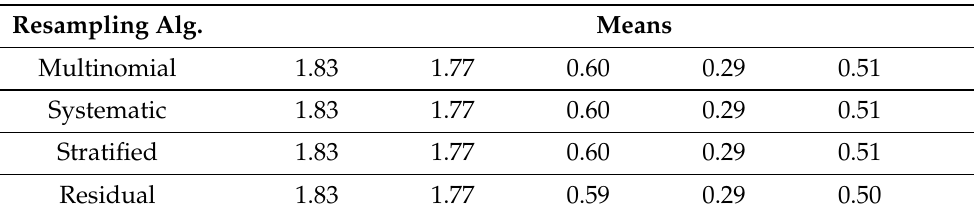
Table 2. Average number of times each of the samples is selected in a test containing 100,000 trials (weights 0.366, 0.354, 0.119, 0.058, 0.102). Resampling Alg.